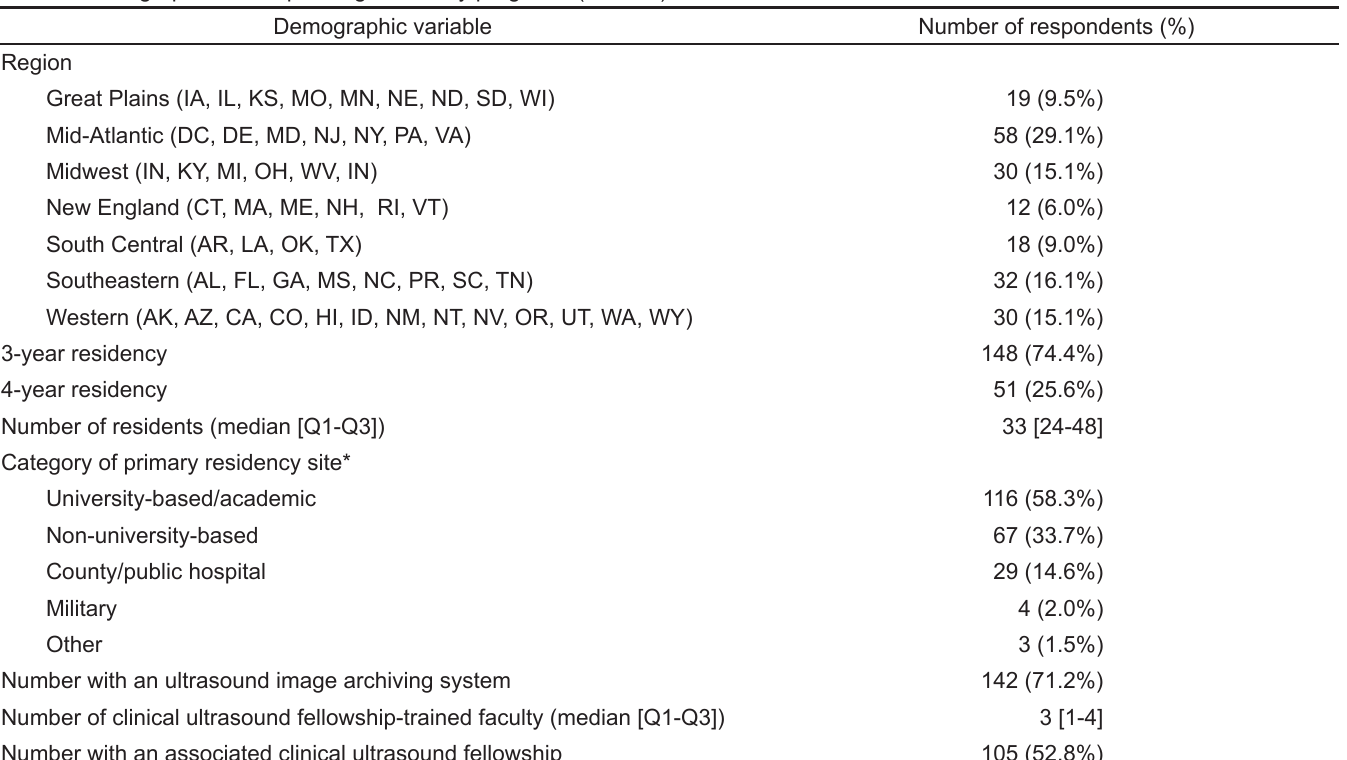
Table 1. Demographics of responding residency programs (n =